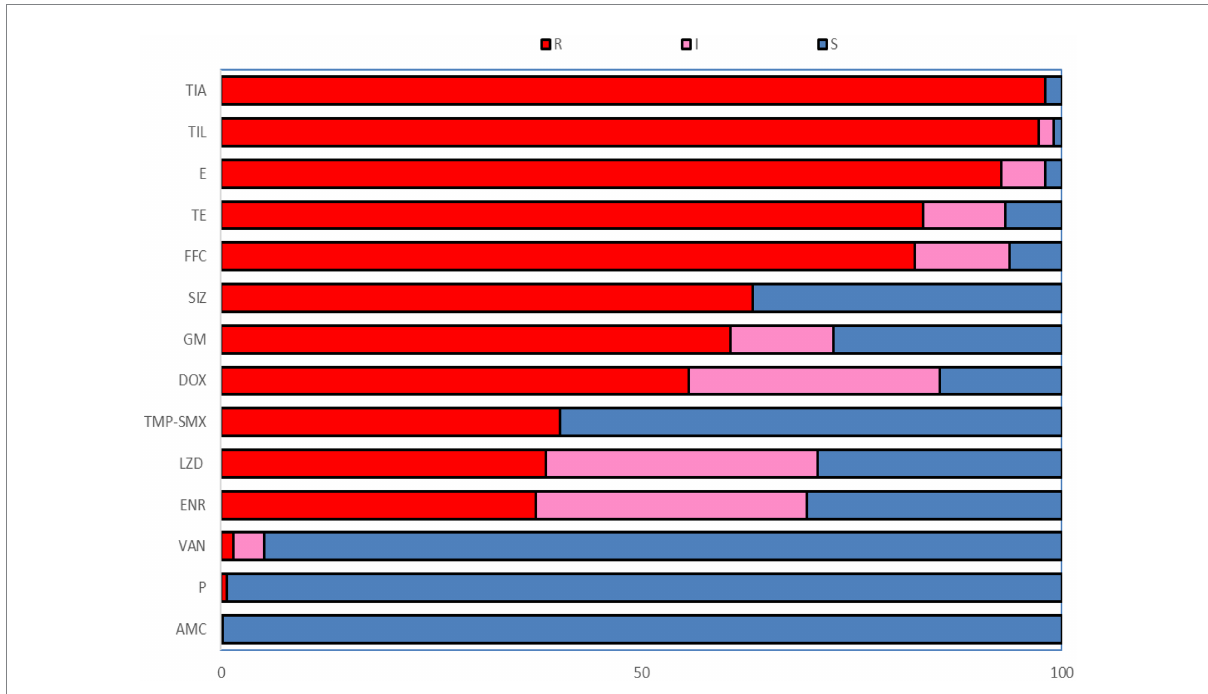
FIGURE 1 The resistance rate to 14 antibiotics of Enterococcus faecalis from swine. R, Resistant; I, Intermediate; S, Susceptible; P, Penicillin; AMC, Amoxicillin/clavulanic acid; GM, Gentamicin; E, Erythromycin; TIL, Tilmicosin; FFC, Florfenicol; SIZ, Sulfisoxazole; TMP-SME, Trimethoprim/ Sulfamethoxazole; VAN, Vancomycin; DOX, Doxycycline; TE, Tetracycline; ENR, Enrofloxacin; LZD, Linezolid; TIA,